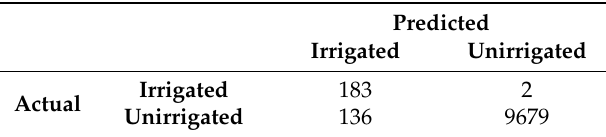
Table 3. Confusion matrix of the binary cross validation dataset weighted according to areal extent of the training data. The points are a spatially independent, randomly sampled cross validation dataset of training data (i.e., ‘Actual’) and IrrMapper inference (i.e.,